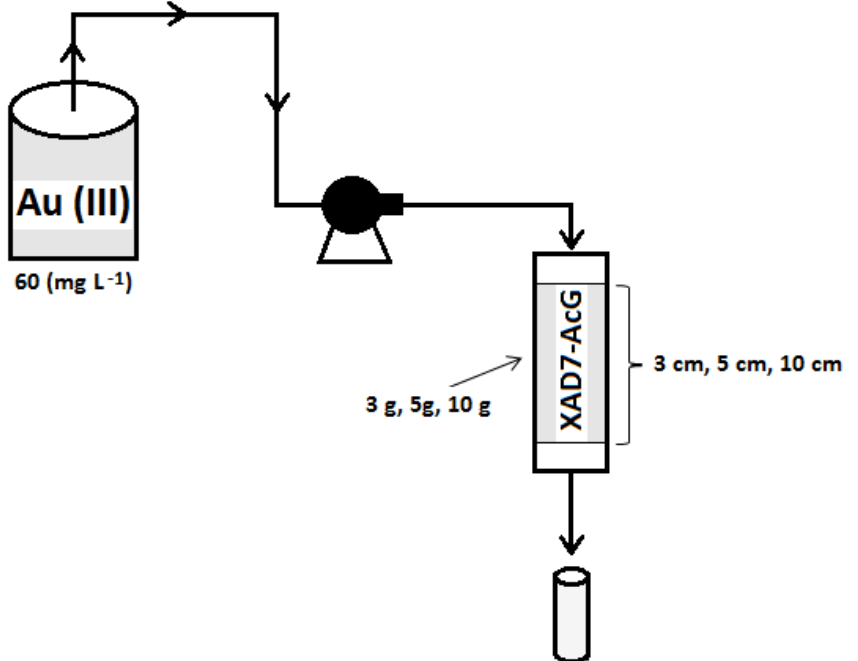
Figure 1. The scheme of experimental installation used for Au (III) removal in a fixed-bed adsorption